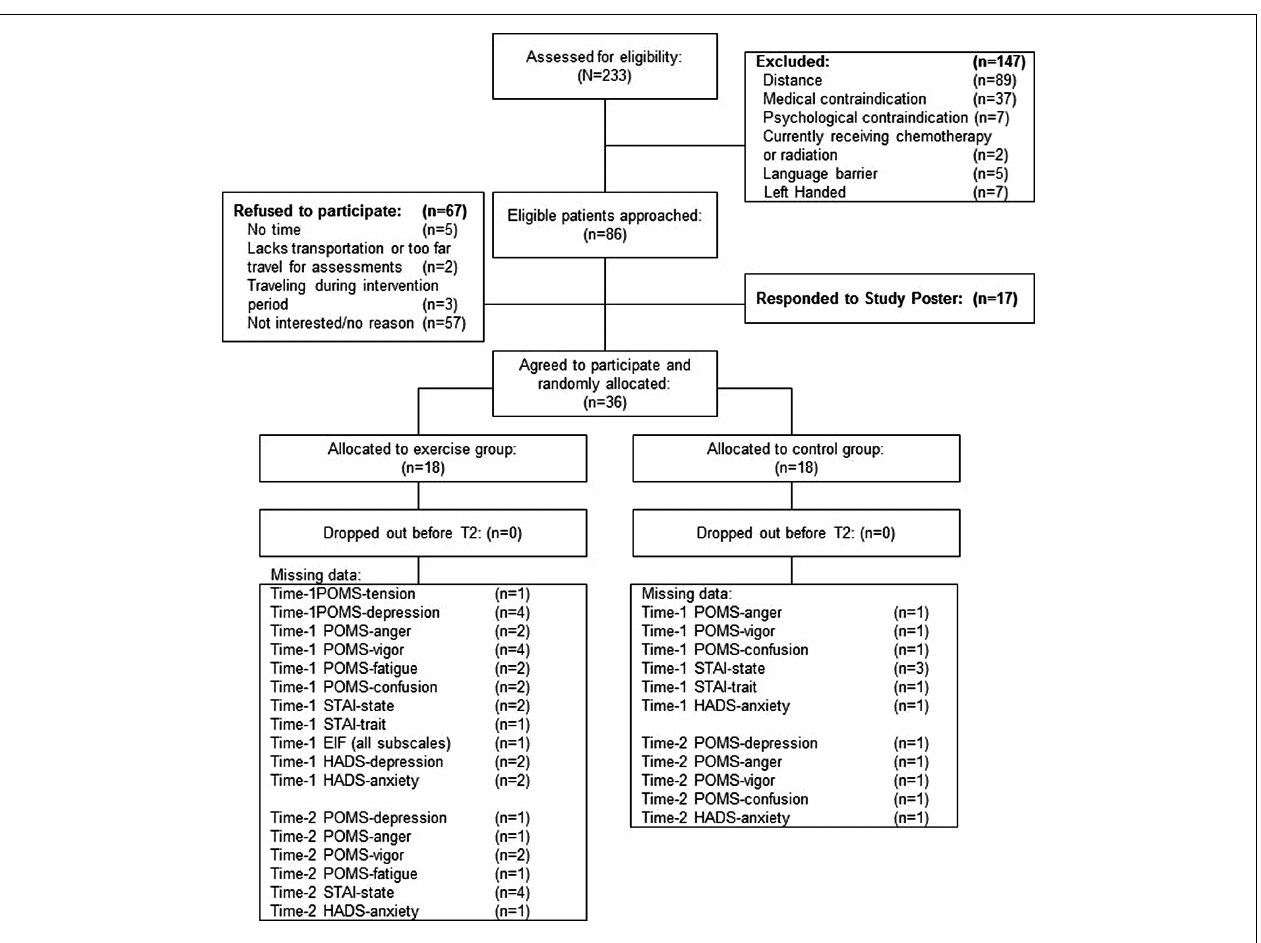
FIGURE 1 | CONSORT